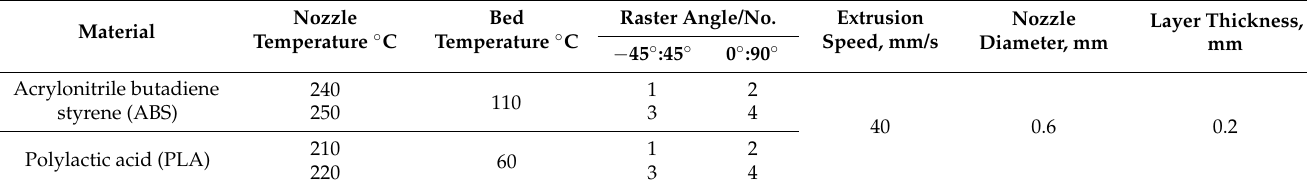
Table 3. Fused deposition modeling (FDM) 3D-printing process parameters.